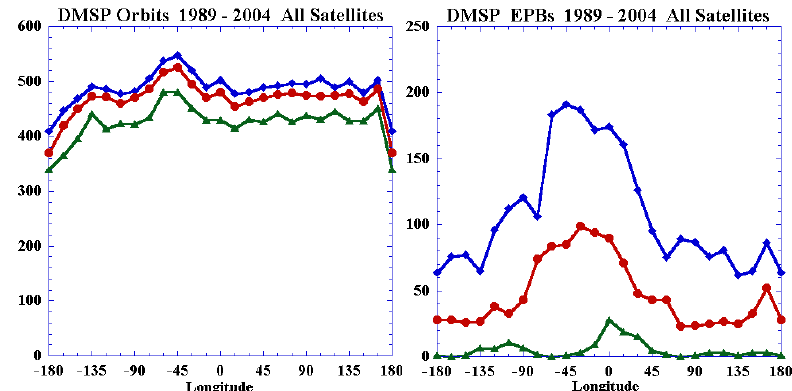
Fig. 1. Maximum, minimum, and median number of orbits (left) and EPBs (right) per month in each longitude sector for 1989-2004 based on data in Tables 2 and 3. Overall, the number of orbits per longitude/month bin ranged from 339 to 548. Highest EPB rates occurred in the America-Atlantic-Africa sector.